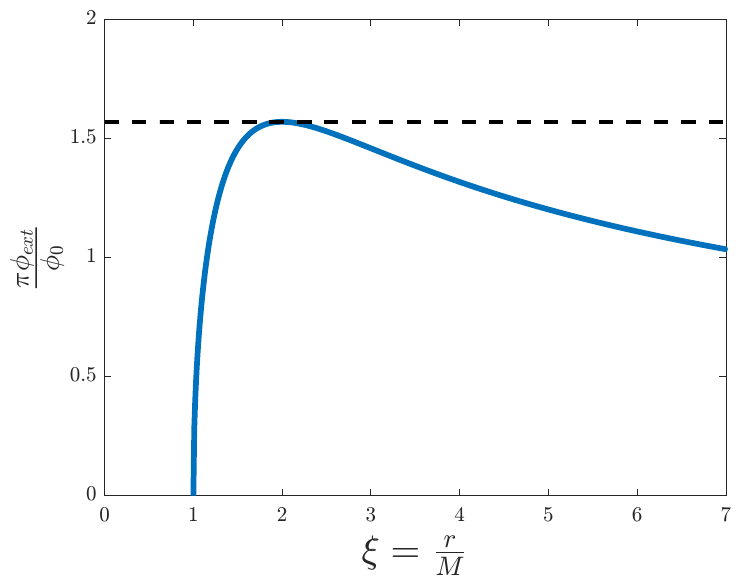
Figure 1. External magnetic flux πφ ext / φ 0 versus the adimensional distance ξ = r / M for the simula- tion of a Schwarzschild black hole. The dashed line represents the threshold value πφ ext / φ 0 = π /2.